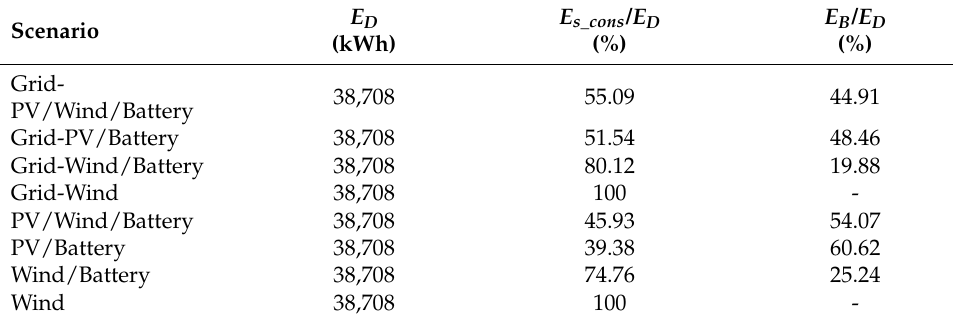
Table 8. Contribution rate to the load energy